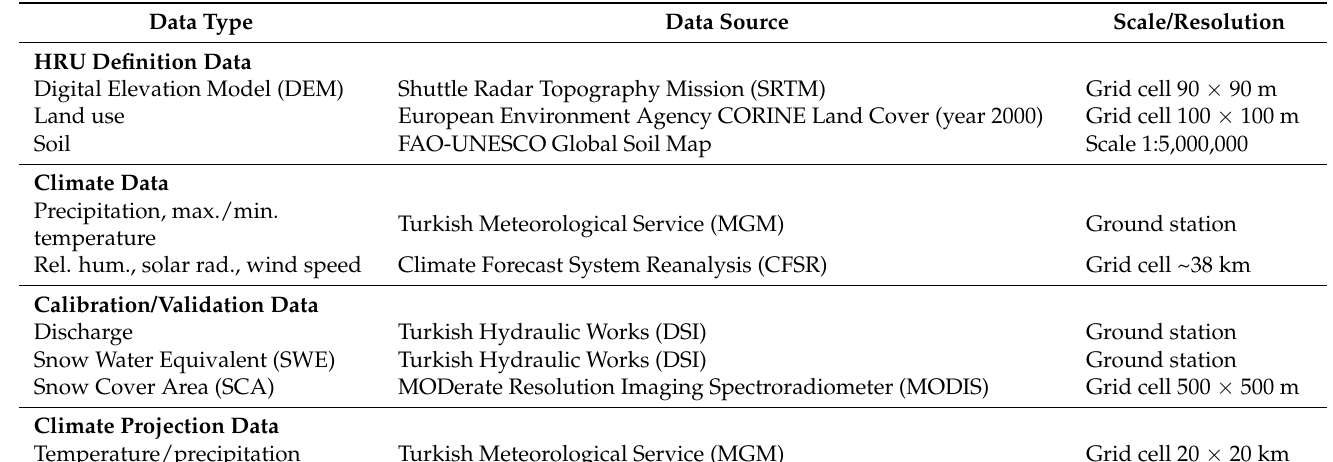
Table 1. Data description, source, and scale/resolution used in